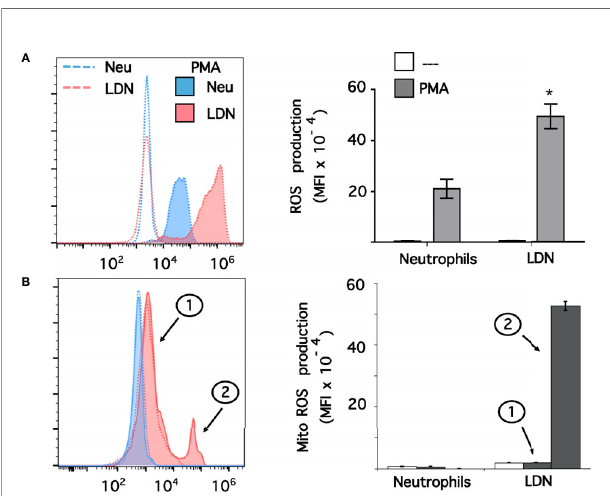
FIGURE 5 | Low-density neutrophils produce more reactive oxygen species than neutrophils. (A) Reactive oxygen species (ROS) production was assessed in dihydrorhodamine 123-loaded cells by detecting fl uoresce changes in fl ow cytometry. (B) Mitochondrial ROS (Mito ROS) production was also assessed in MitoSOX ™ Red-loaded cells. Neutrophils (blue) or low- density neutrophils (LDN) (red) were left untreated ( — ), or were stimulated with 20 nM PMA (shaded histograms). The majority of LDN (peak 1) did not produced any mitochondrial ROS. A small fraction (13%) of LDN produced mitochondrial ROS after PMA stimulation (peak 2). Histograms (left panels) are representative of 9 separate experiments (A) or 3 separate experiments (B) with similar results. ROS production is indicated by the mean fl uorescence intensity (MFI). Data (right panels) are the Mean ± SEM. Asterisks denote conditions that were statistically different between stimulated neutrophils and stimulated LDN (*p <